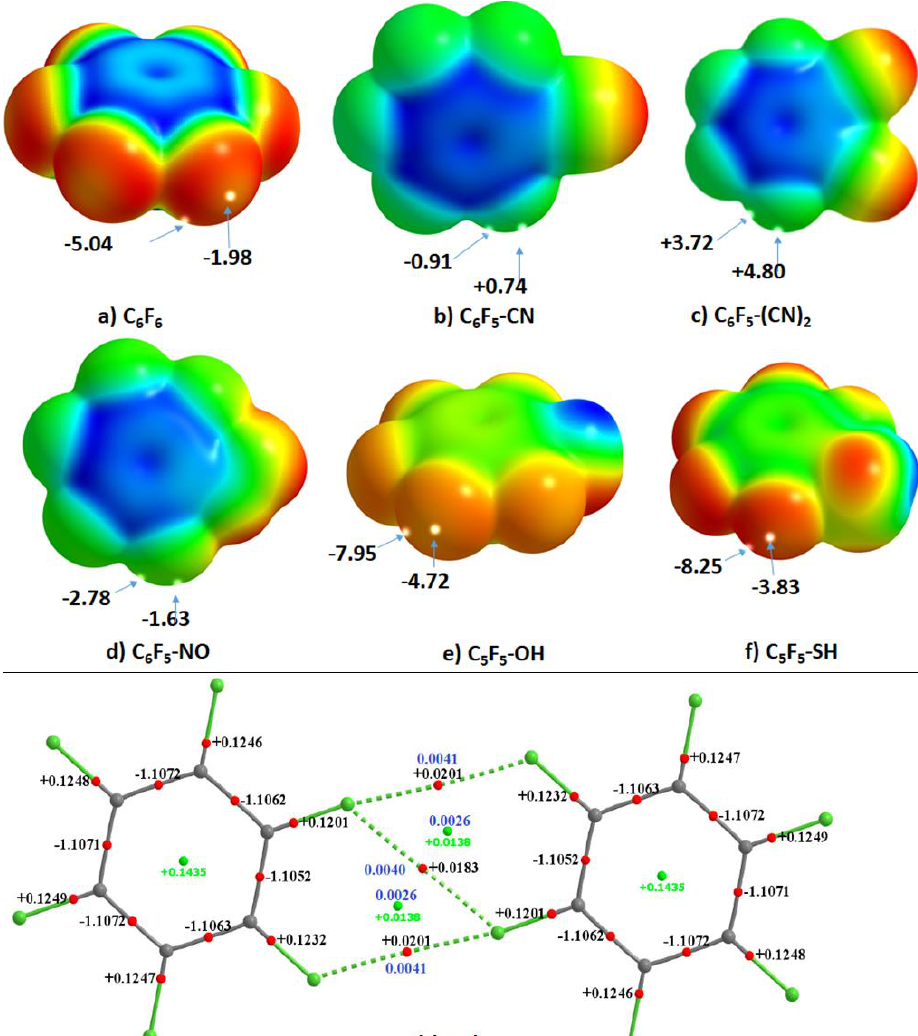
Figure 5. ( a – f ) PBE/6-311++G(2d,2p) level 0.0010 a.u. isodensity mapped molecular electrostatic surface potential of some partially and fully fluorinated aromatic compounds. The maximum and minimum ( V s,max and V s,min (in kcal mol − 1 ), respectively) of MESP are shown on some fluorine atoms in a few of these compounds, demonstrating anisotropy in the charge density. For clarity, yellow dots representing V s,max and V s,min are shown only for a few cases (Color: blue—strongly positive; red—strongly negative). ( g ) The MP2/cc-pVTZ level QTAIM molecular graph of the (C 6 F 6 ) 2 homomolecular dimer [49], formed even when the fluorine in the C 6 F 6 monomer is entirely negative. The charge density ( ρ b /a.u., blue) at selected F · · · F bcps and rcps, and the Laplacian of the charge density ( ∇ 2 ρ b /a.u., black) at all bcps and rcps are shown. Bcps: tiny red spheres; rcps (ring critical points): tiny green spheres; bond paths: solid and dotted lines in atom color; solid and dotted lines represent the open- and closed-shell interactions,